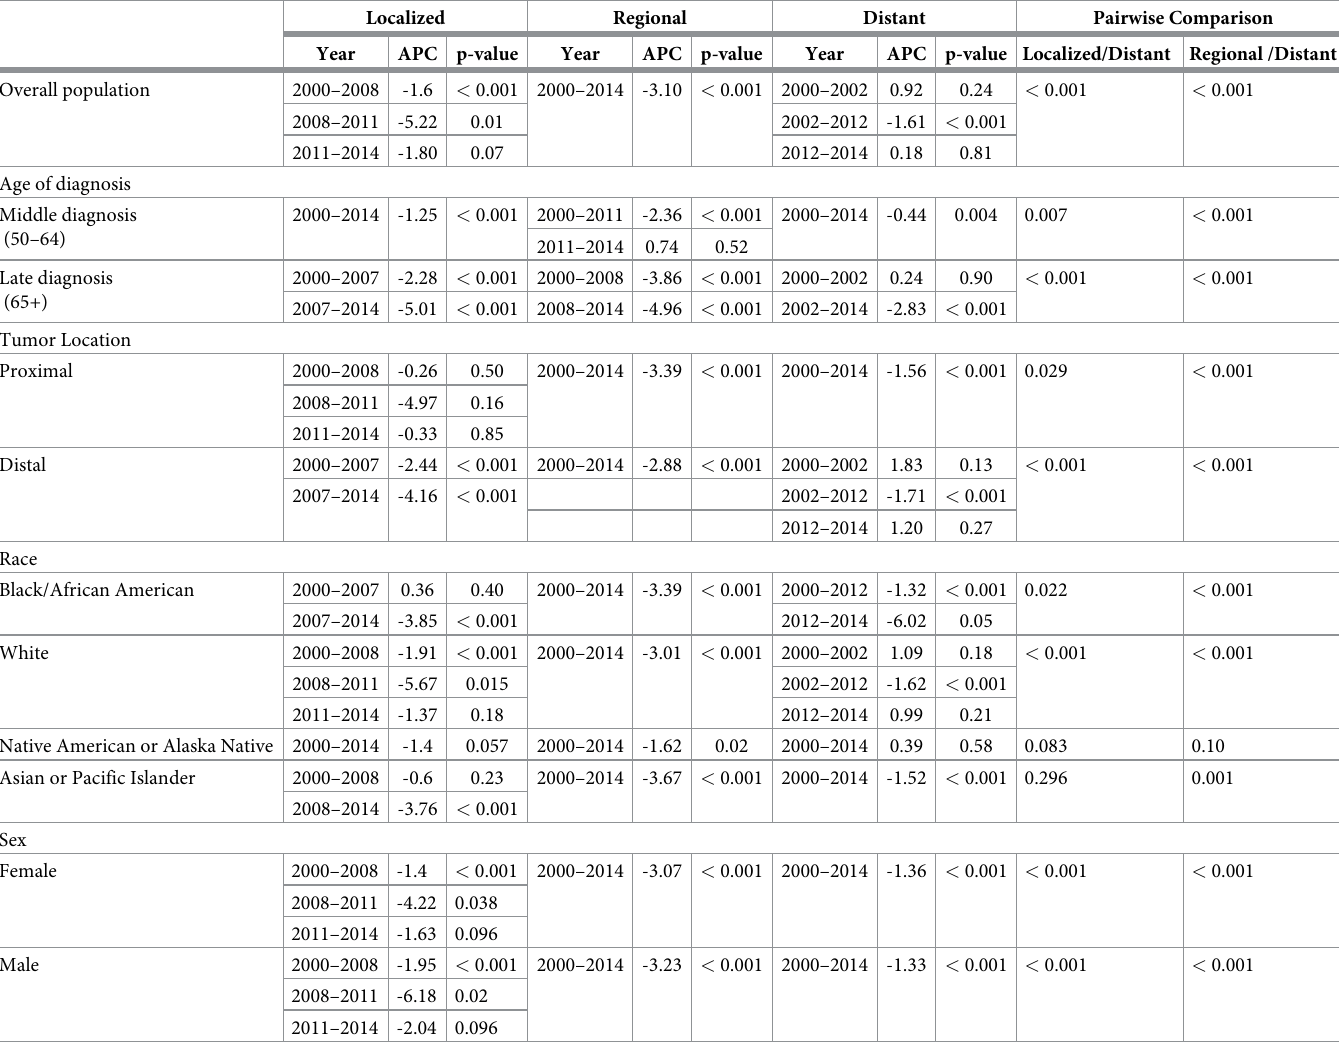
Table 1. Summary of localized, regional, and distant joinpoint